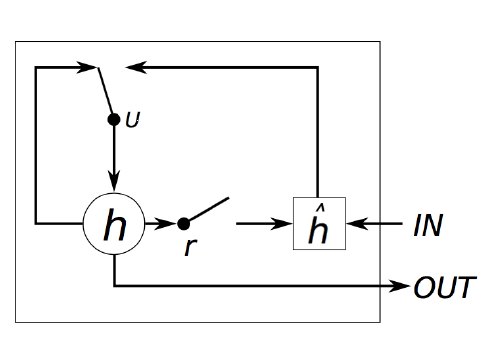
Figure 1. Structure of a Gated Recurrent Units (GRU) cell